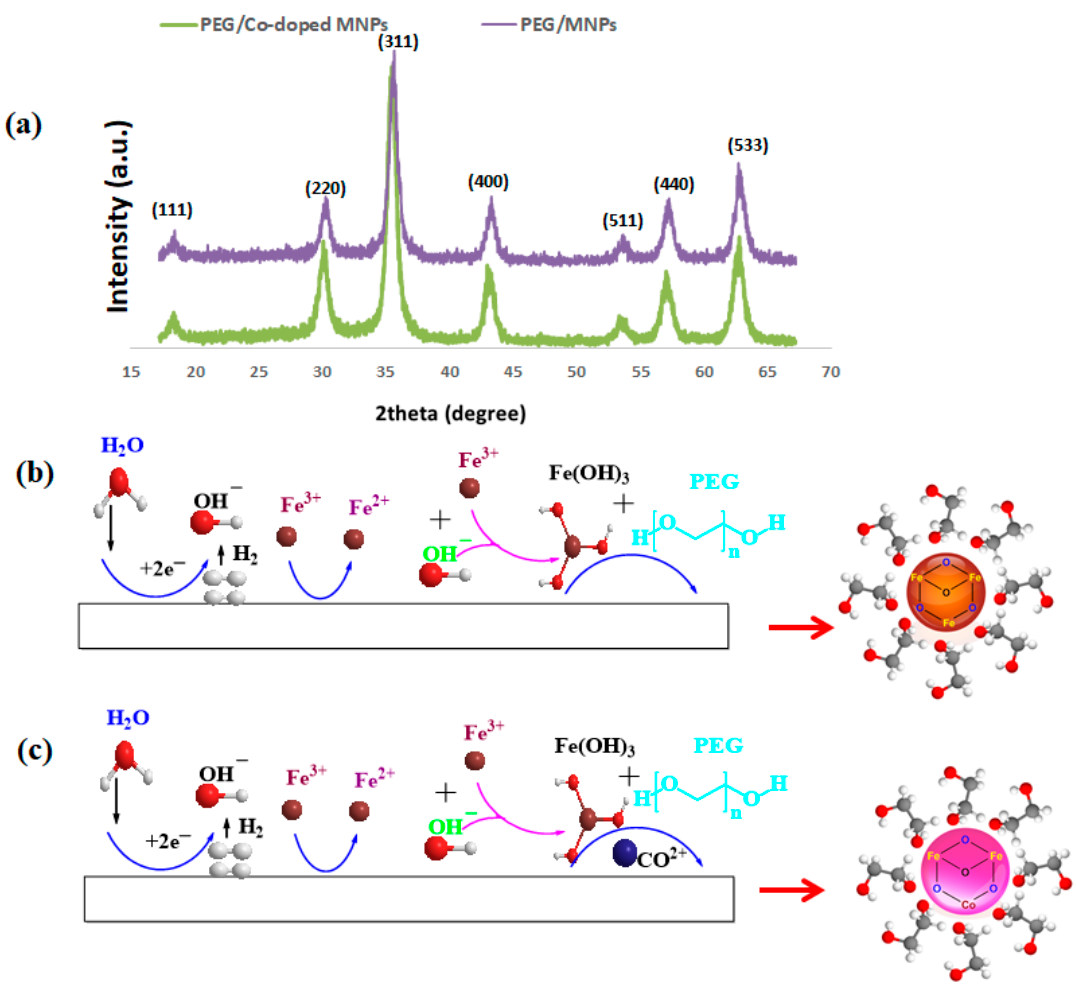
Figure 2. ( a ) XRD patterns of the PEG-MNPs and Co-doped PEG-MNPs; and ( b , c ) schematic mechanism of preparation of PEG-MNPs and Co-doped PEG-MNPs, respectively.